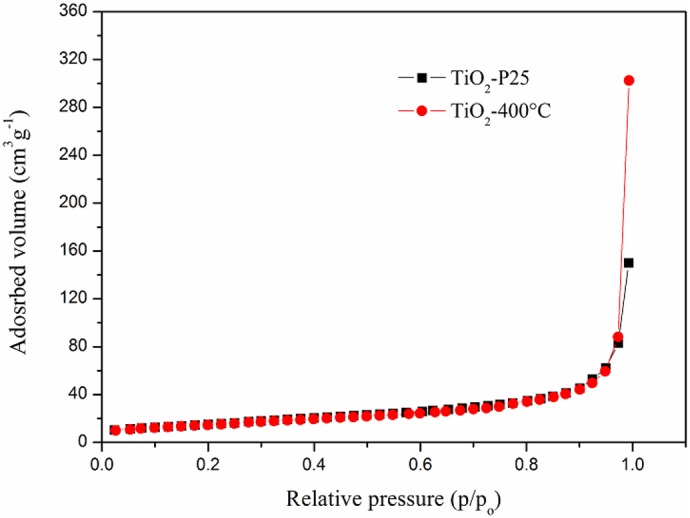
Nitrogen adsorption isotherms of the TiO2-P25 powder before and after calcination at 400 °C (TiO2-400 °C).